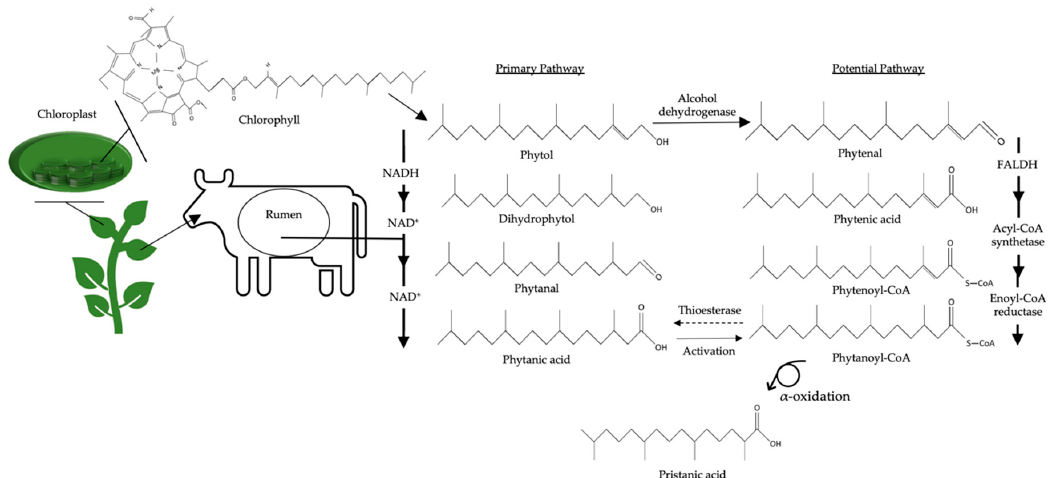
Figure 3. Synthesis of phytanic and pristanic acid via rumen microorganisms derived from chlorophyll within forages NAD: Nicotinamide adenine dinucleotide. NAD + : the oxidized form of NAD. NADH: the reduced form of NAD (protonated with a hydrogen).